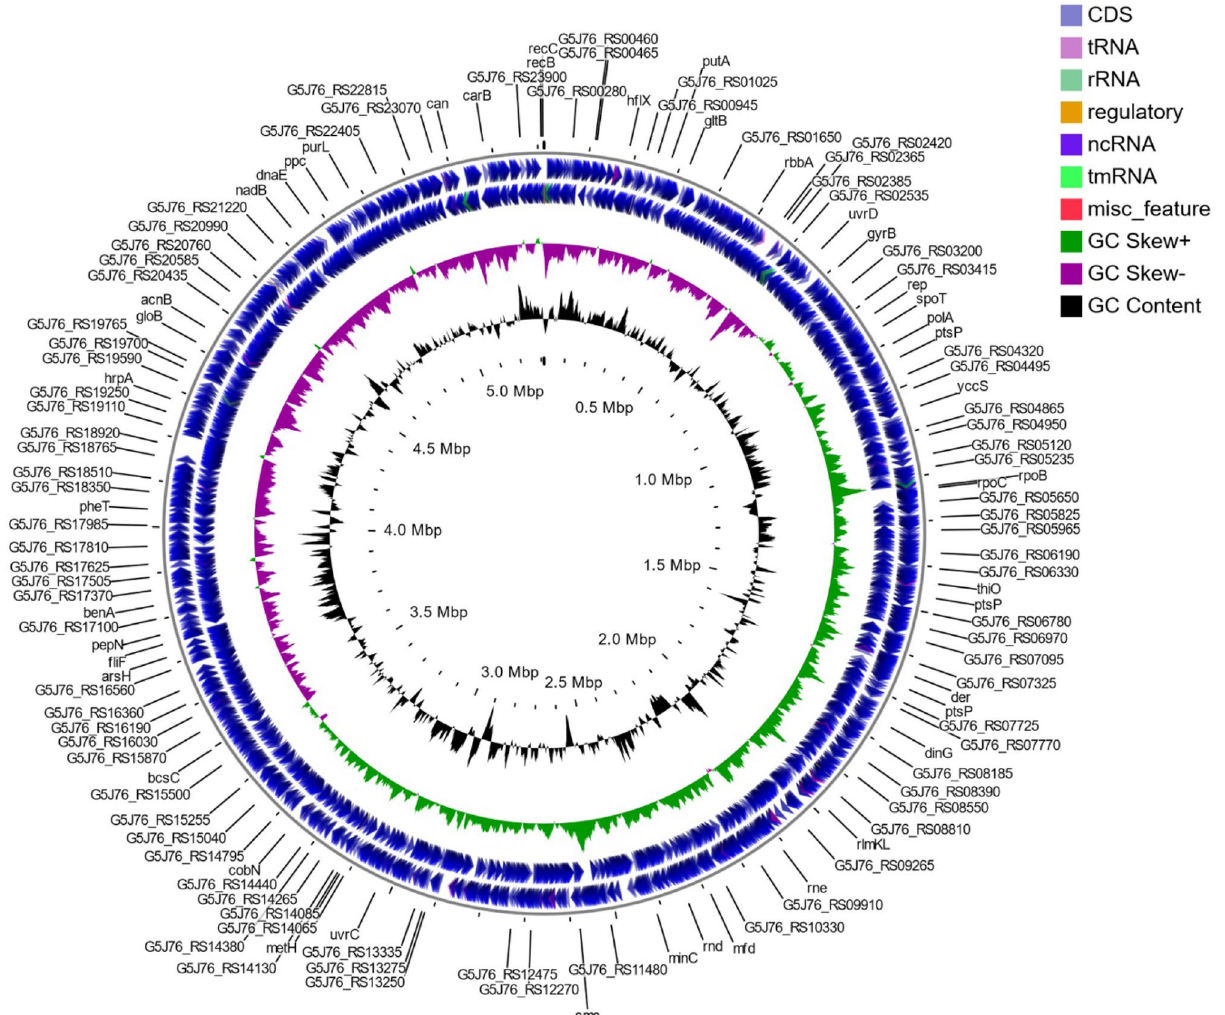
Figure 1. Circular representation of the P. psychrophila KM02